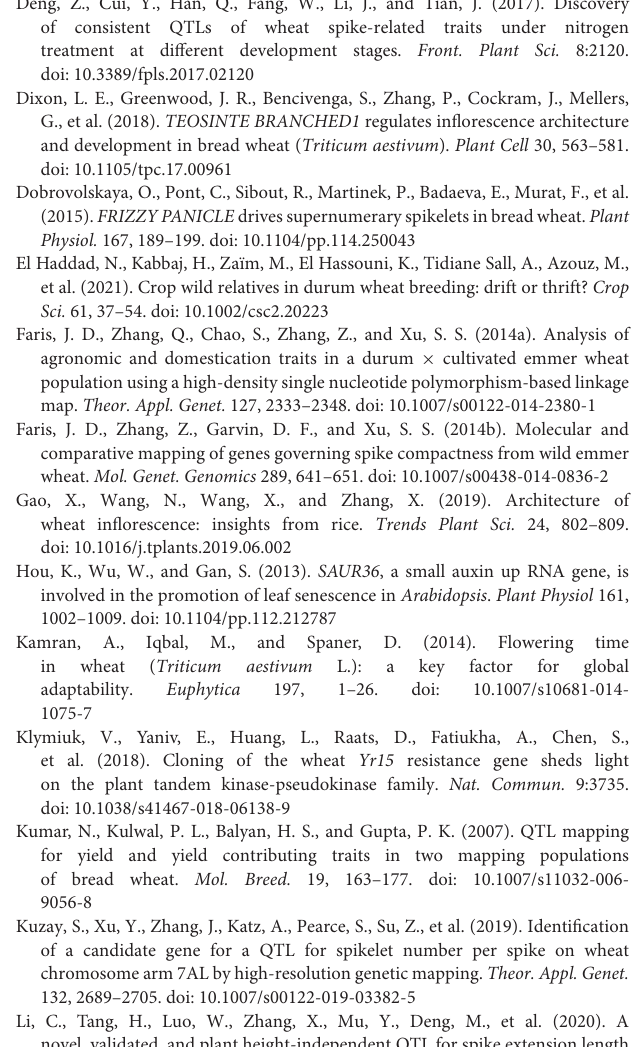
Supplementary Table 6 | Details of kompetitive allele-specific PCR (KASP) markers. Supplementary Table 7 | Comparison of the major QTL with loci previously reported for